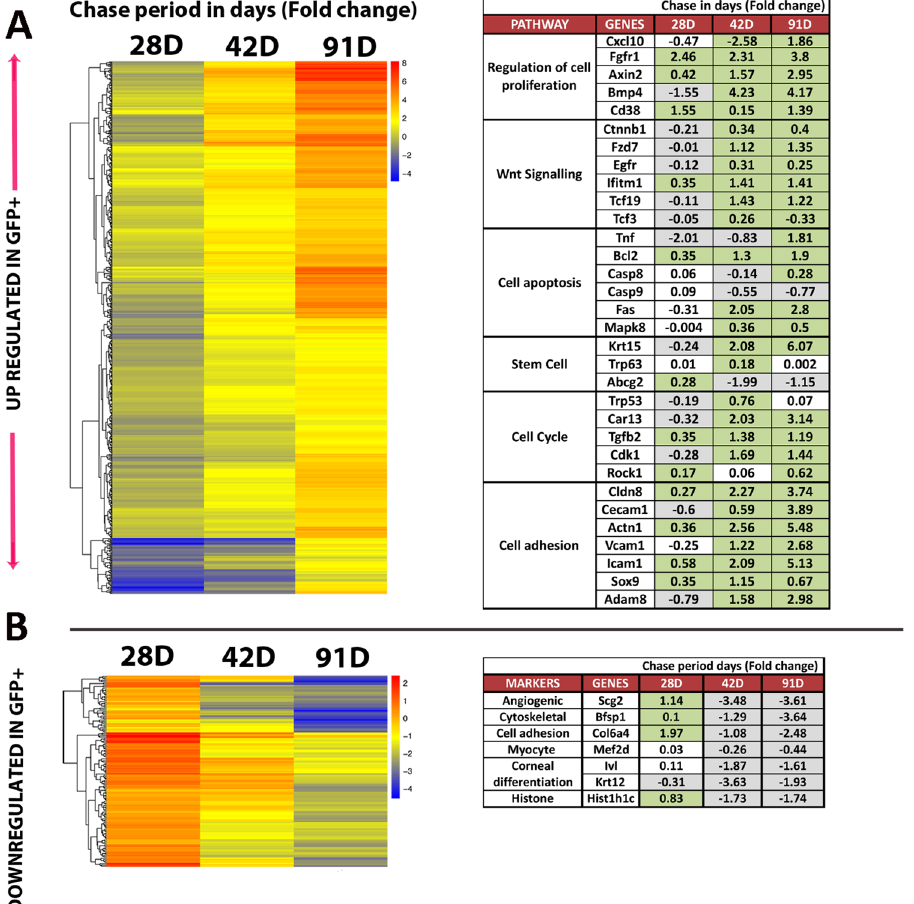
Figure 3. RNA-Seq analysis of GFP + LRCs and GFP − corneal epithelial cells from K5tTA × TRE-H2BGFP highlights the up-regulated and down-regulated genes in GFP + LRCs over time. ( A ) Heatmap of 651 up regulated genes in GFP + LRCs showing differences in gene expression between GFP − and GFP + cells represented in a single column at each chase period. The colors of the heat map representing single genes changing from blue to red across the chase periods indicate enrichment of gene expression in GFP + LRCs. The table enlists pathways and genes involved in stem cell activation, maintenance and proliferation in GFP + LRCs. ( B ) Heatmap of 135 down regulated genes in GFP + LRCs. Blue represents low expression in GFP + , and red high expression in GFP + . The table indicates key genes involved in cell division and differentiation. Highlighted green boxes in the table represent significant high expression in GFP + LRCs; Grey boxes represent significant high expression in GFP − cells; No color indicates no significant difference between GFP + and GFP − cornea